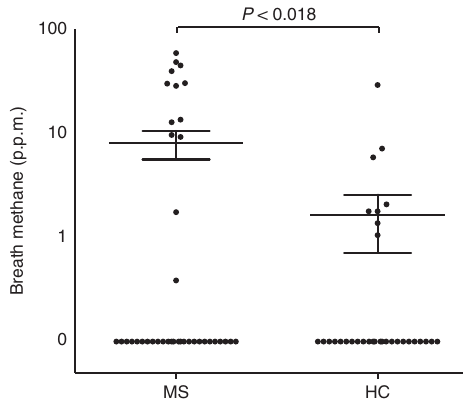
Figure 4 | Measurement of breath methane production in MS patients ( n ¼ 41) and controls ( n ¼ 32). Breath methane measured in each subject is represented on the y axis in parts-per-million on a logarithmic scale. The mean and s.e.m. are shown by the indicated horizontal lines. 28 of 41 MS patients and 24 of 32 controls had no detectable